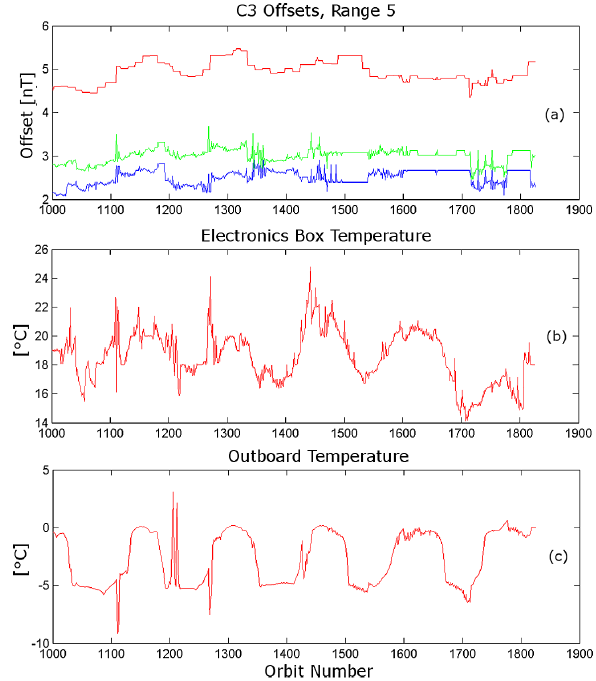
Figure 15. (a) C2 range 5 offsets ( O 1 in red, O 2 in blue and O 3 in green), (b) C2 electronics box temperature and (c) C2 out- board sensor temperature. Offsets shown in nanoteslas and temper- atures in degrees Celsius for orbits 1000–1812 (December 2006– February 2012).